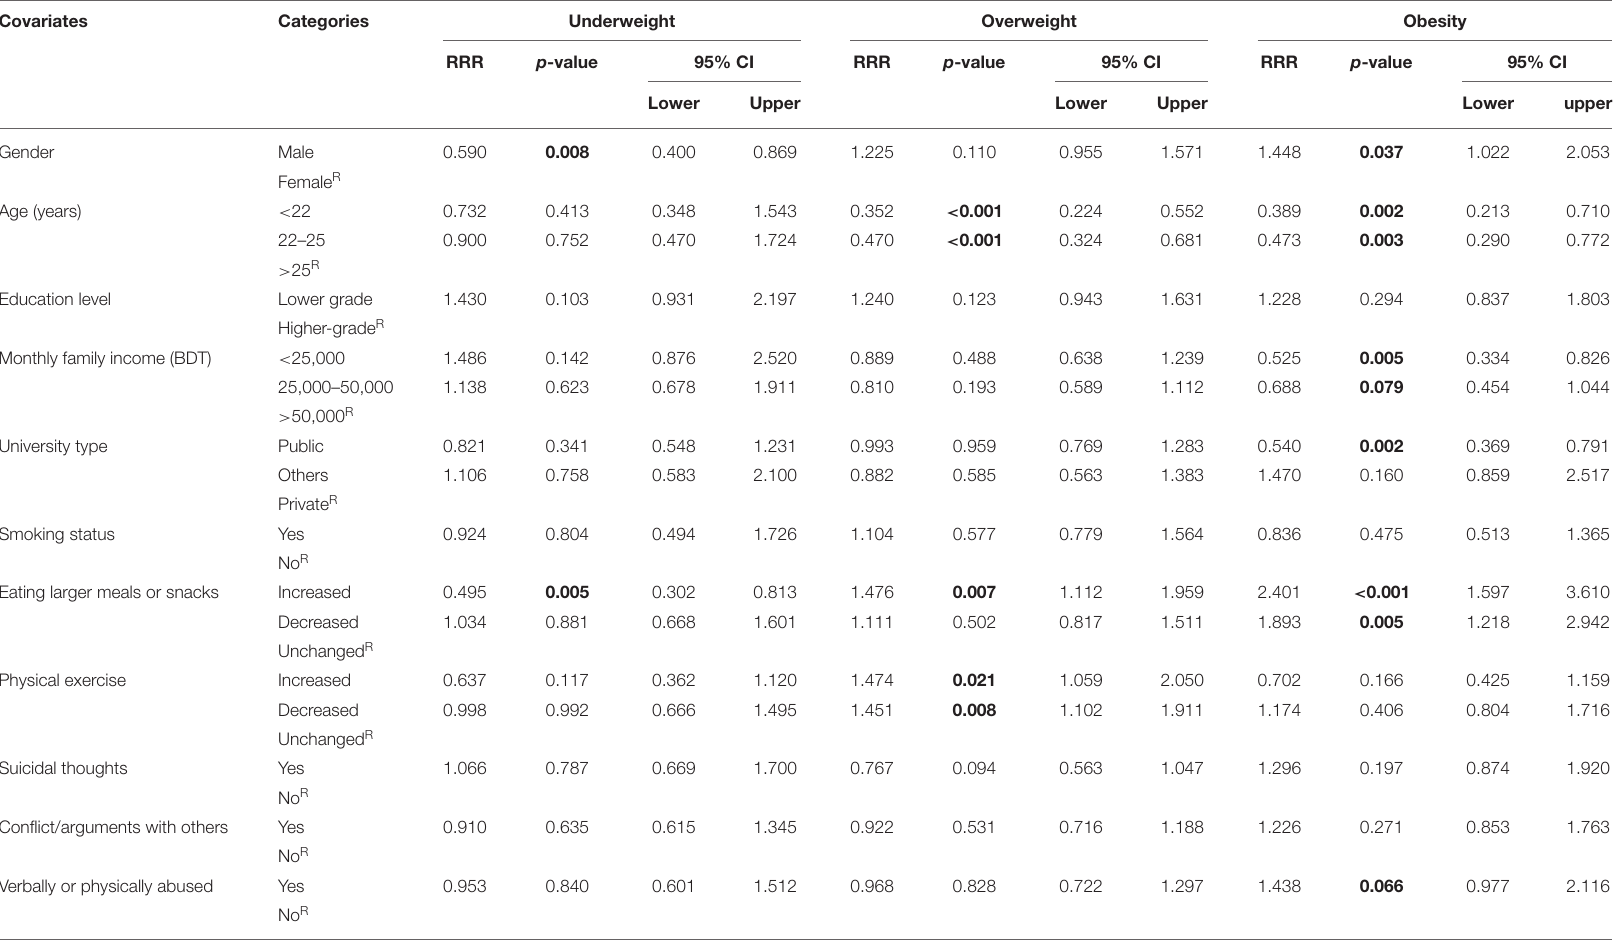
TABLE 4 | Adjusted relative risk ratio (RRR) from multinomial logistic regression analysis for underweight, overweight, and obese respondents in comparison with normal weight respondents of university students following prolonged COVID-19 lockdown in Bangladesh.